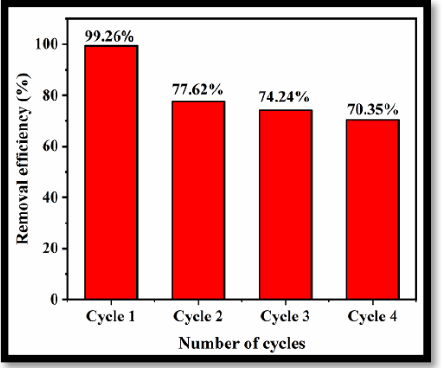
Figure 12. Reusability of rGO-WO 3 adsorbent for removal of LVX.